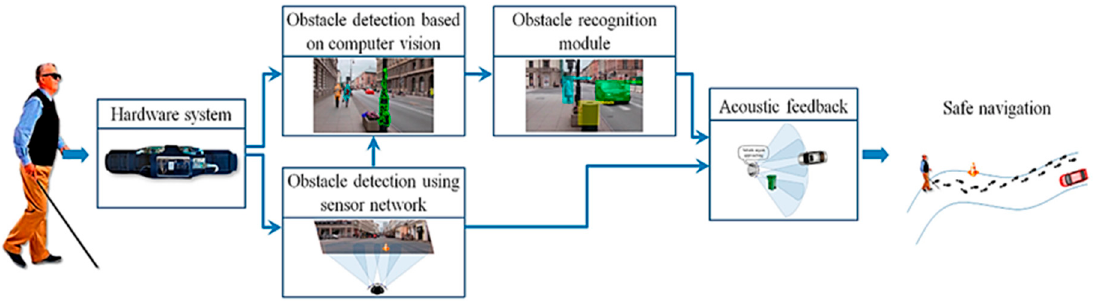
Figure 39. The process of the proposed navigation system [60].